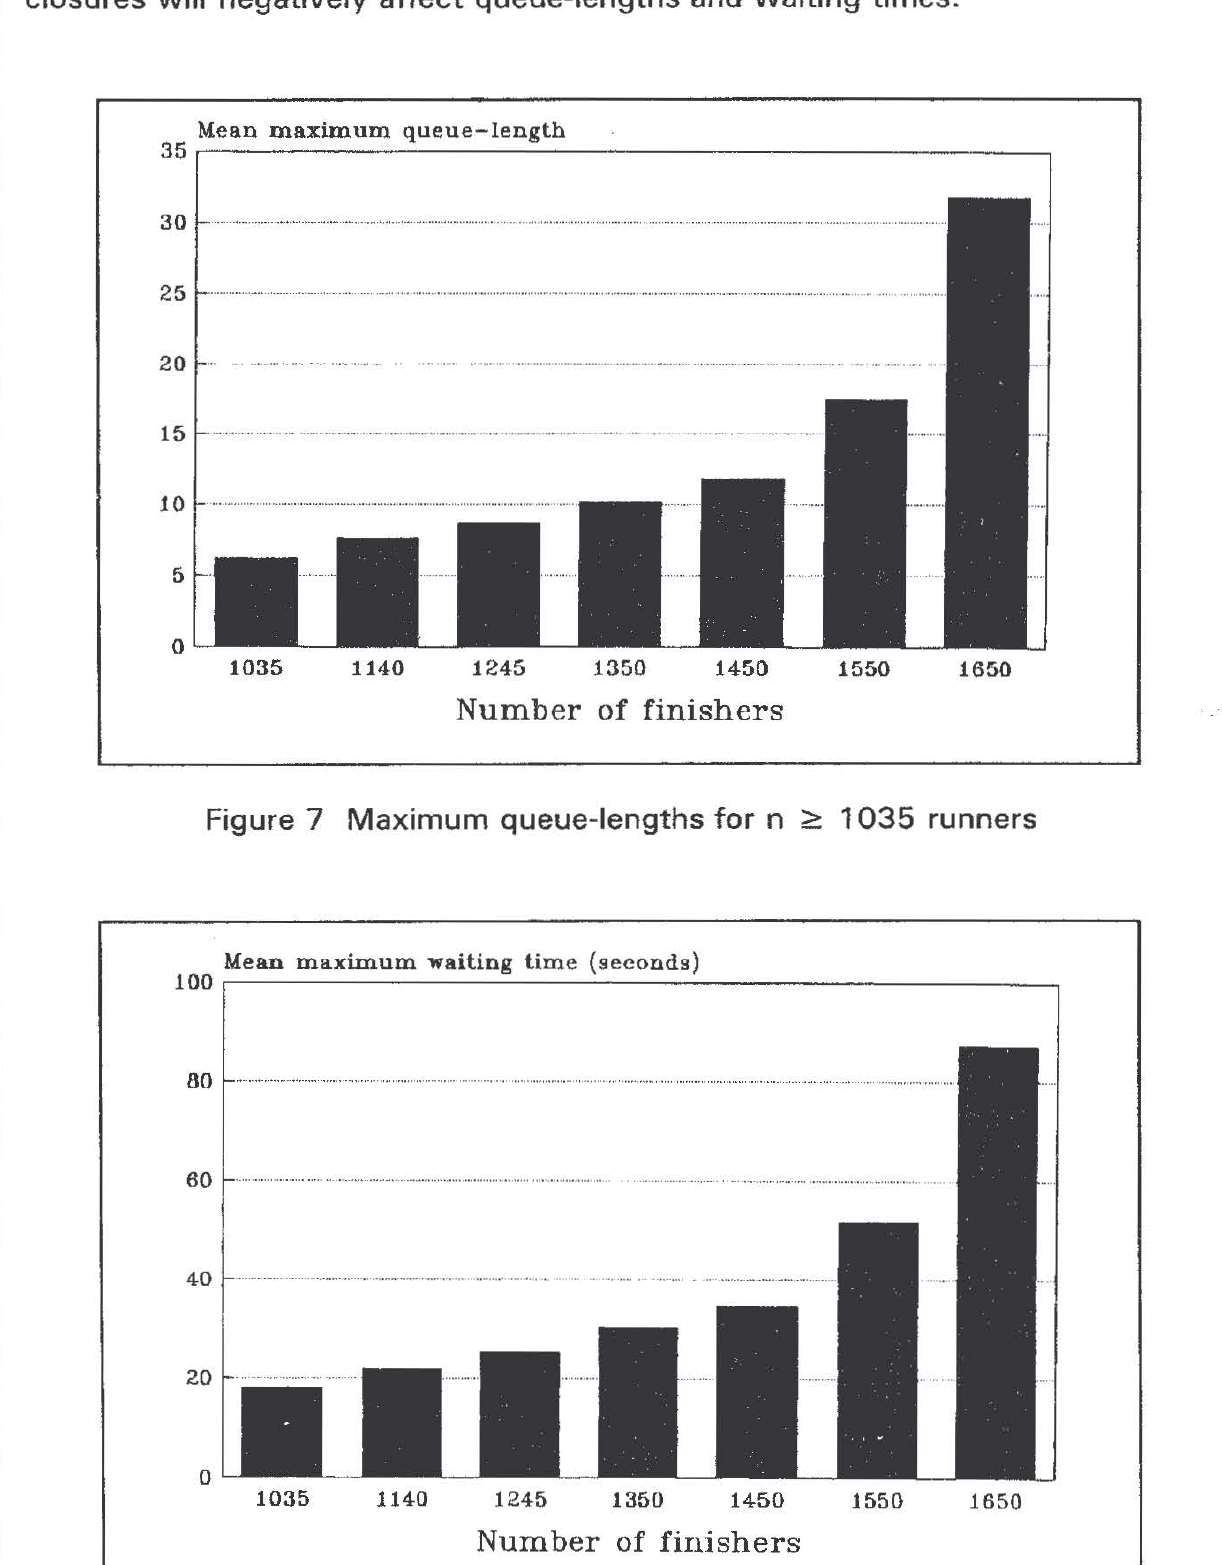
Figure 7 Maximum queue-lengths for n > 1 035 runners